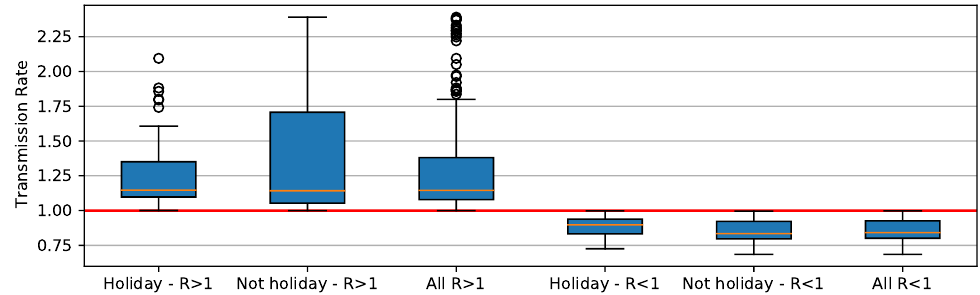
Figure 9. Boxplot distribution of R 0 value for holidays and non-holidays.